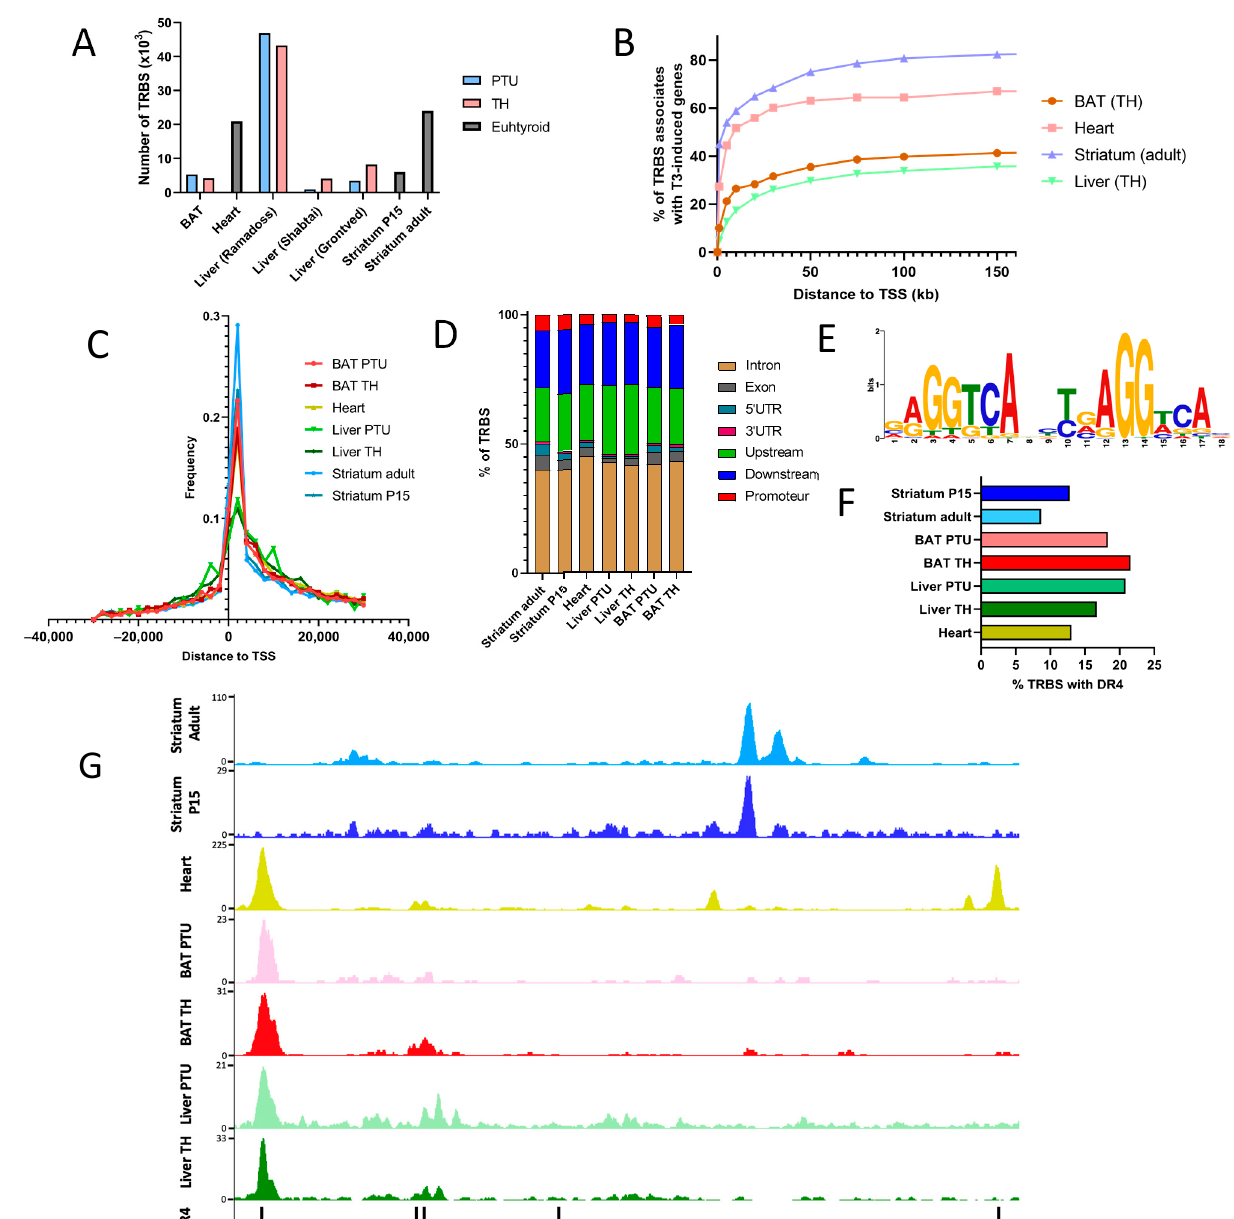
Figure 2. TR chromatin occupancy. ( A ) Number of TR binding sites (TRBS) in each of the available tissues. The different thyroid statuses are indicated by a color code (blue: hypothyroid by exposure to PTU, pink: TH injection, grey: euthyroid). ( B ) Percentage of genes upregulated by T3 that possess a TRBS depending on the distance (in kilobase) chosen to attribute a TRBS to a gene. We generally observed three phases: a very high enrichment of T3 induced when considering TRBS within 10 kb, a high enrichment for TRBS within 30 kb and a plateau above 50 kb. Thus, we chose 30 kb as a distance to attribute a TRBS to a gene, as a compromise to maximize the number of TR target genes while minimizing false positives. ( C ) Frequency of TRBS relative to their distance from the transcription starting site (TSS). ( D ) Distribution of TRBS in different gene regions. ( E ) Consensus sequence identified by a de novo motif search in brown adipocytes. All available tissues display a similar DR4 element to the top enriched motif. ( F ) Percentage of TRBS that possess a DR4. ( G ) Extract of the Integrative Genome Viewer (IGV) in the promoting region of Hcn2 . Each tissue is represented by a different color, and DR4 elements are represented by black vertical lines at the bottom of the IGV shot.